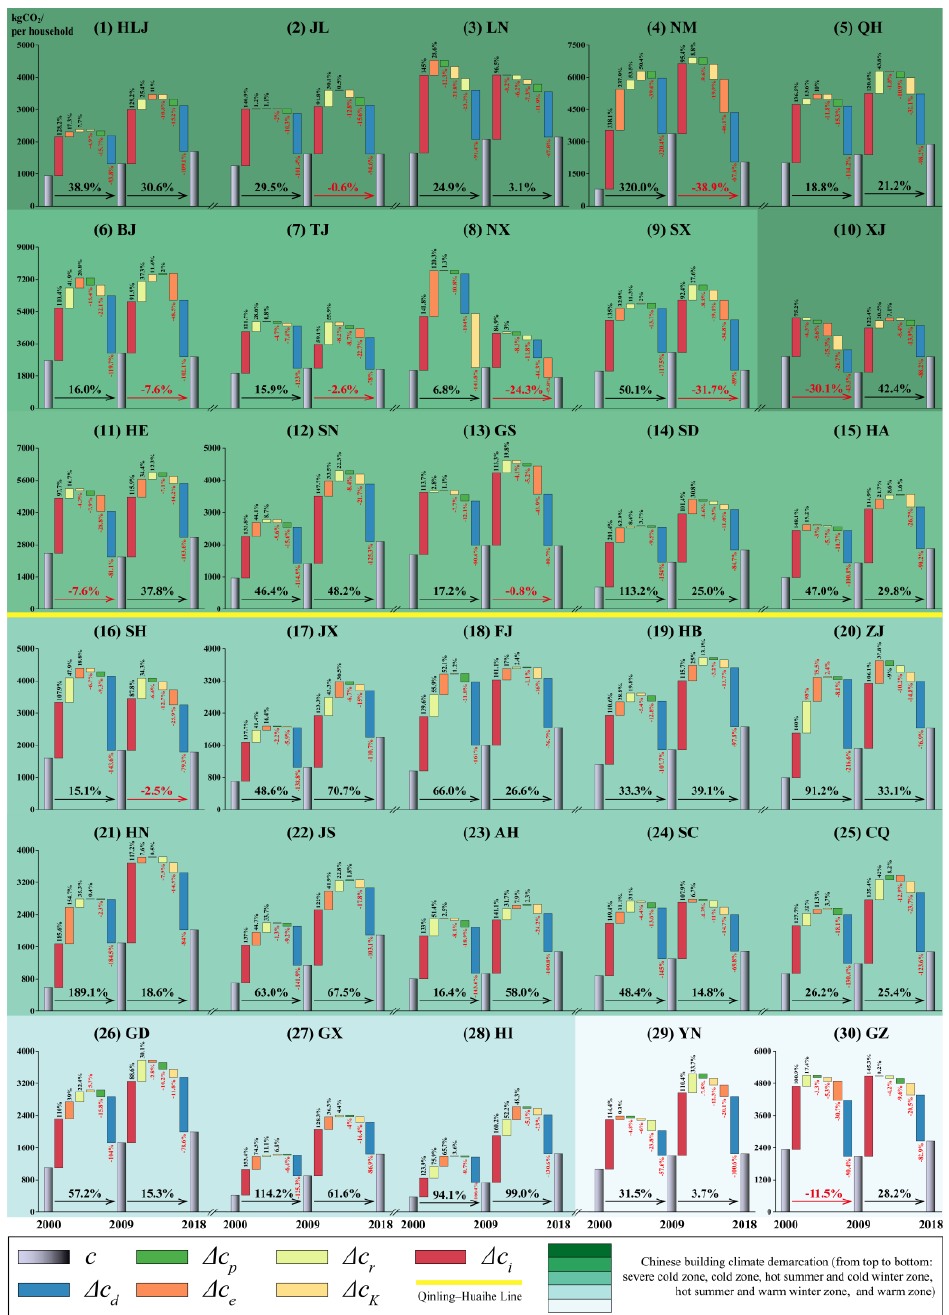
Figure 1. Changes in carbon intensity of provincial residential building operations (2000 – 2018).